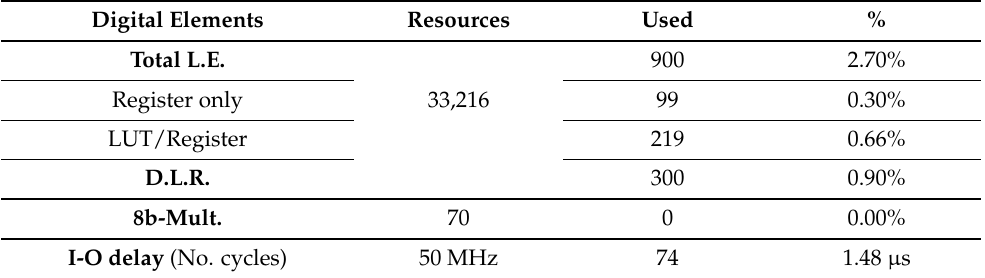
Table 9. Hardware resources used by CORDIC multiplier.